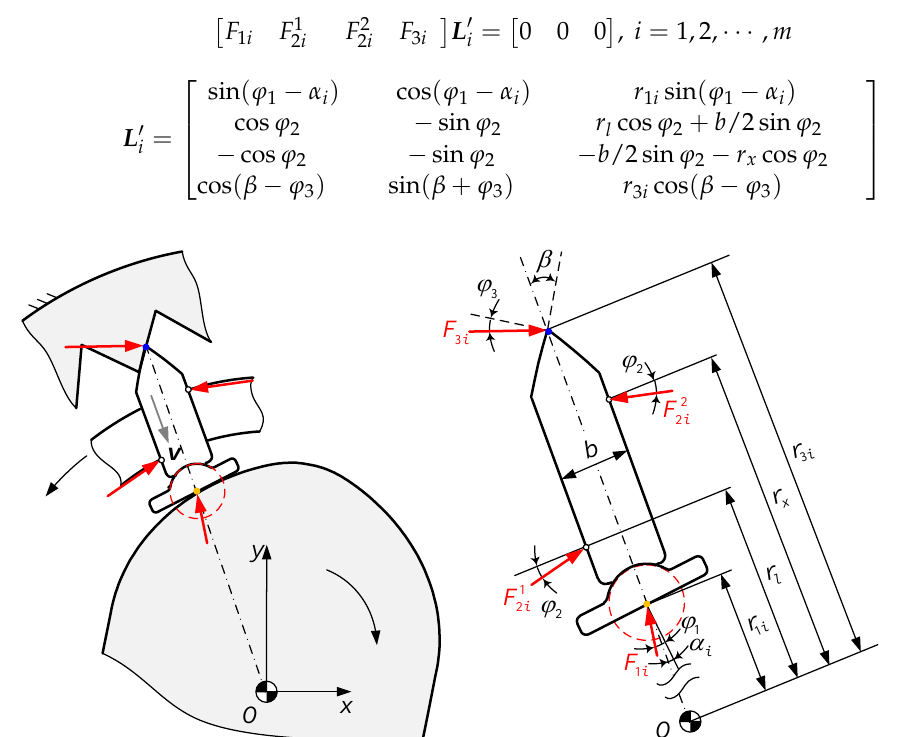
Figure 16. Force state of the i -th tooth during the return travel.